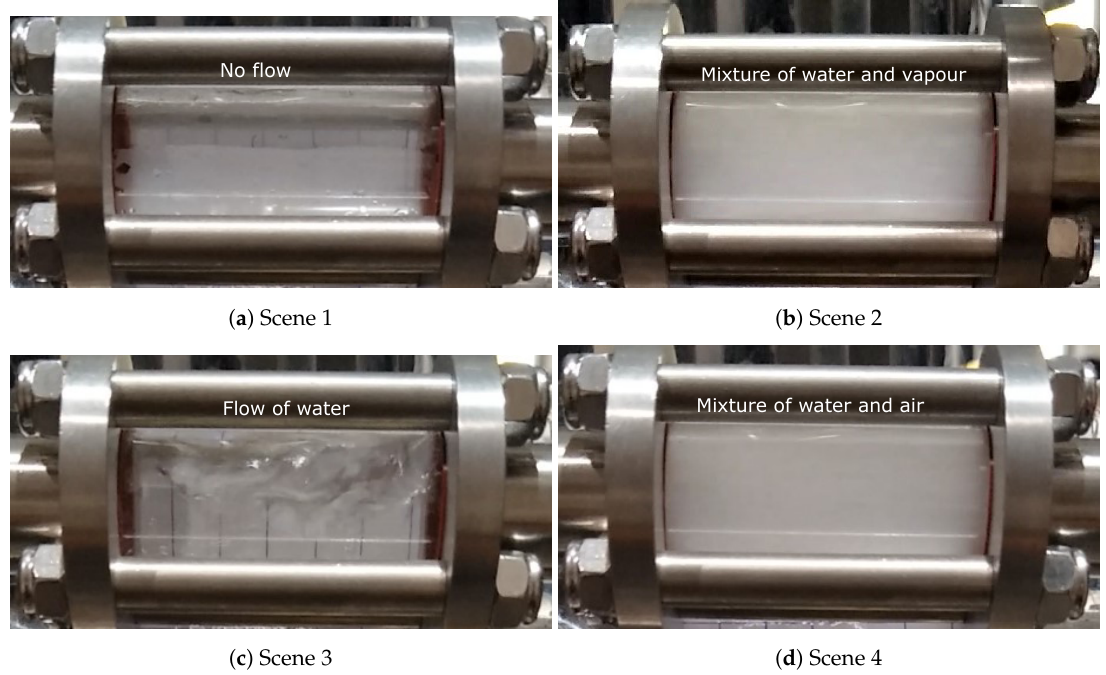
Figure 14. Different scenes observed from the recorded video of the sight glasses in the production process